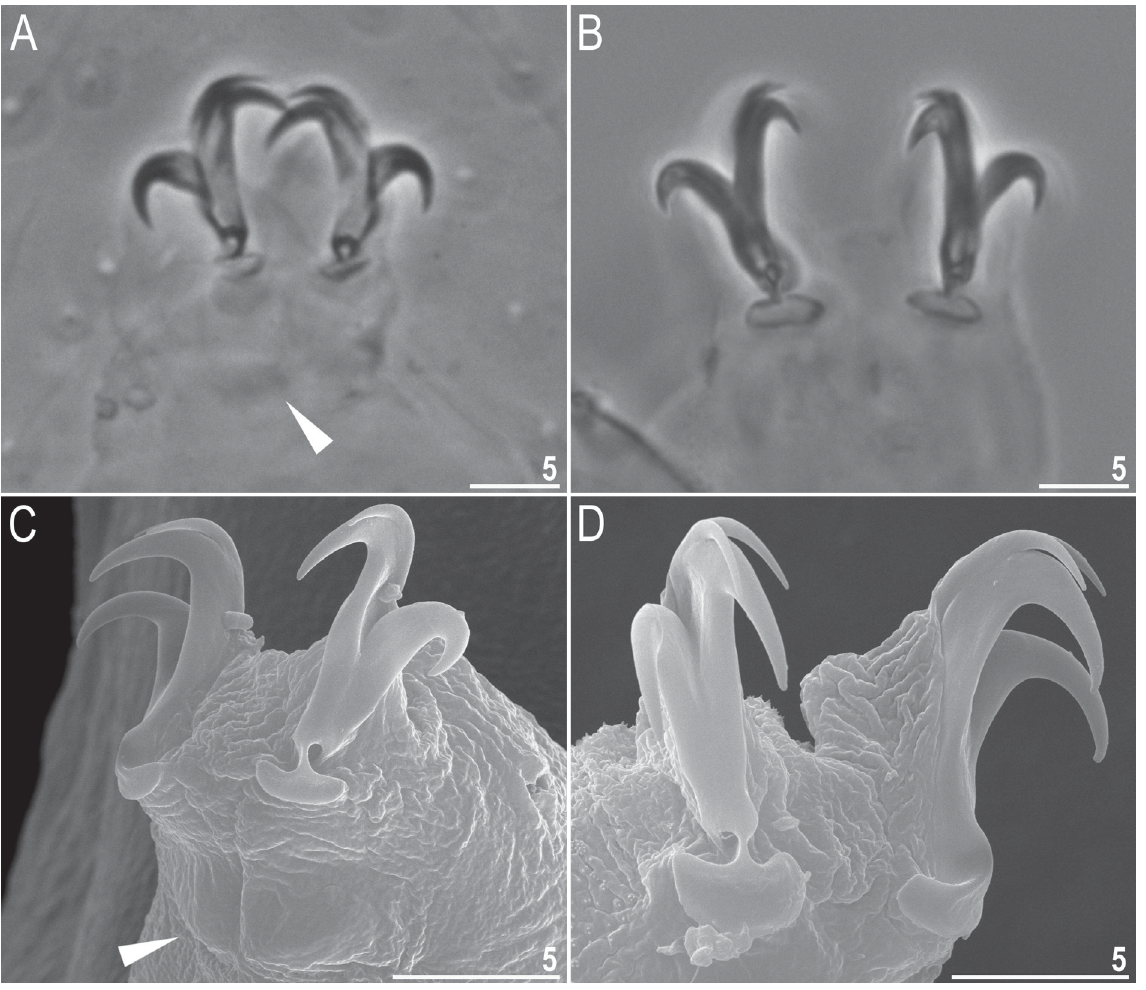
Fig. 5. Macrobiotus canaricus sp. nov., paratypes, claws. A–B . Claws III and IV seen under PCM. C–D . Claws I and IV seen under SEM. Arrowheads indicate faint muscle attachments under claws; Figs A and B assembled from several photos. Scale bars in